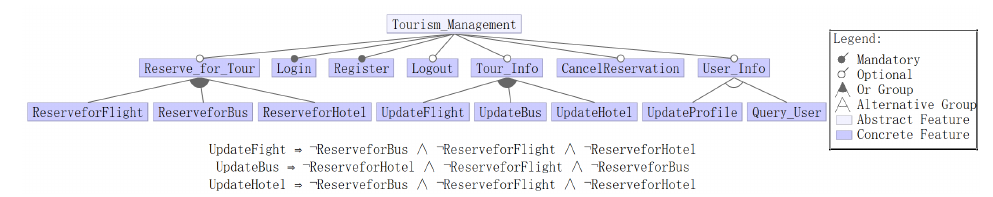
Figure 1. The feature model of Tourism